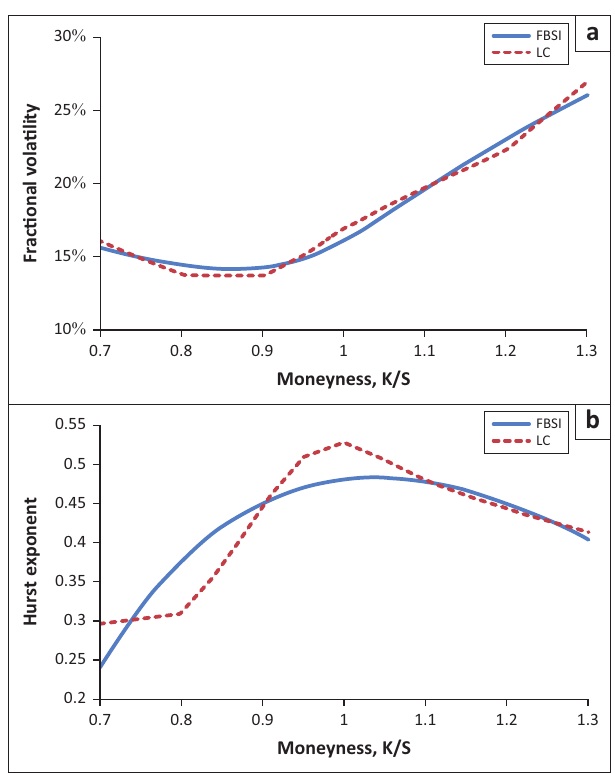
FIGURE 9: Calibrated (a) fractional volatility and (b) Hurst exponent skews from the FBSI and LC models as at 30 May